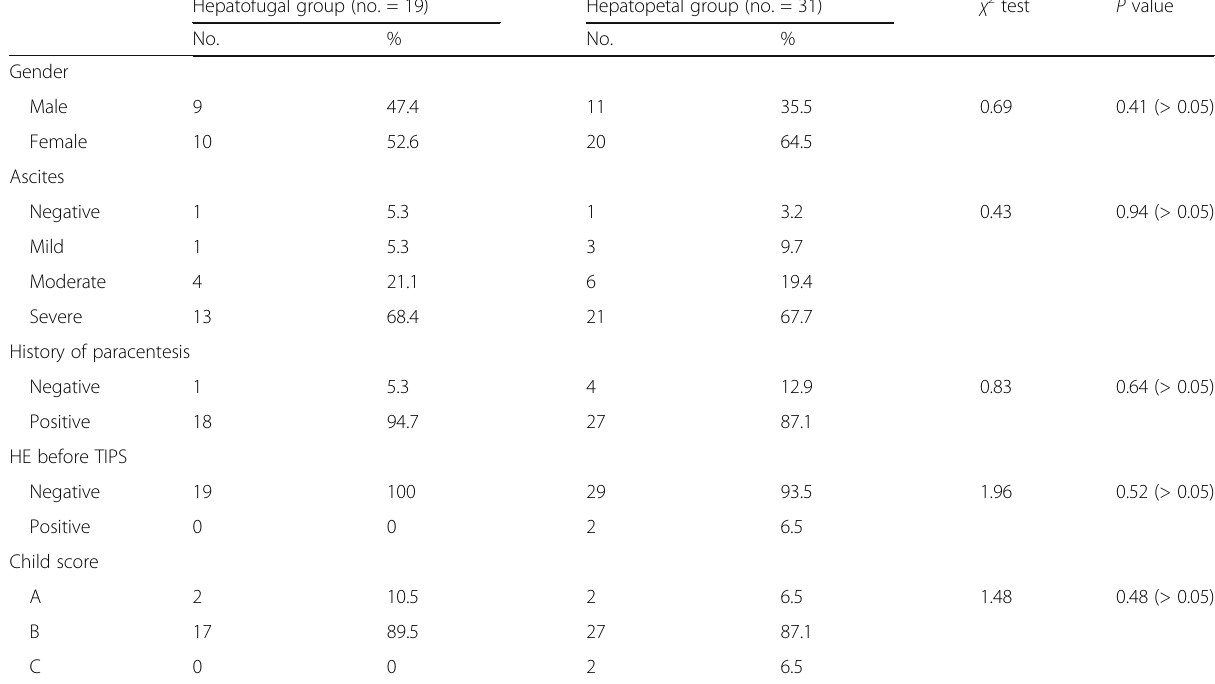
Table 1 Clinical characteristics of the studied groups before TIPS Hepatofugal group (no. = 19)